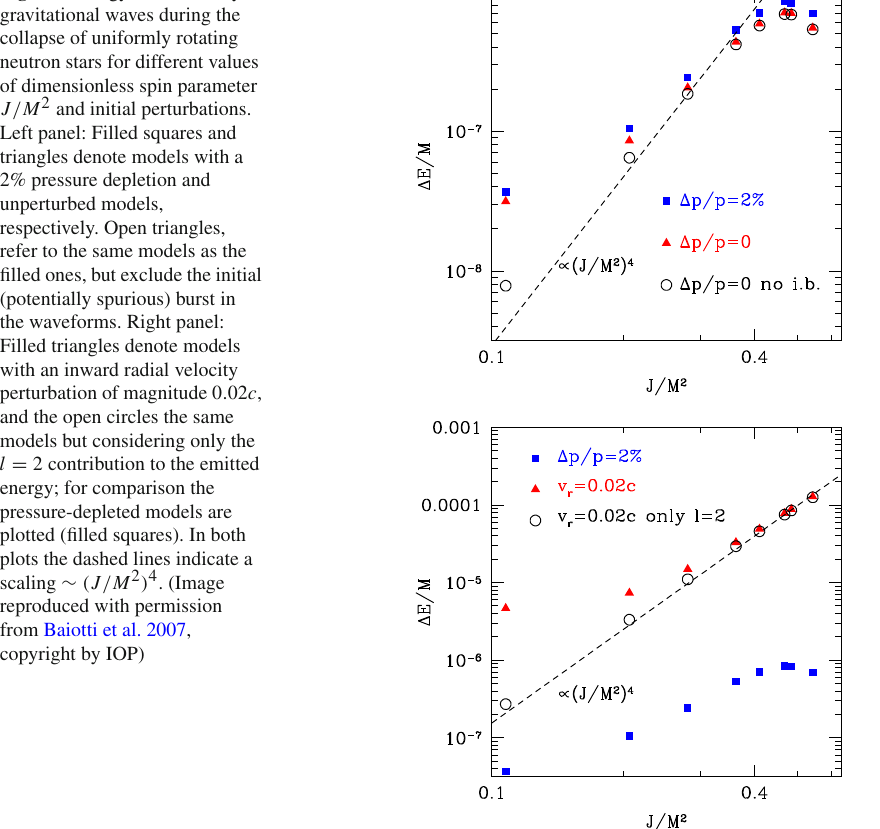
Fig. 24 Energy carried off by gravitational waves during the collapse of uniformly rotating neutron stars for different values of dimensionless spin parameter J / M 2 and initial perturbations. Left panel: Filled squares and triangles denote models with a 2% pressure depletion and unperturbed models, respectively. Open triangles, refer to the same models as the filled ones, but exclude the initial (potentially spurious) burst in the waveforms. Right panel: Filled triangles denote models with an inward radial velocity perturbation of magnitude 0 . 02 c , and the open circles the same models but considering only the l = 2 contribution to the emitted energy; for comparison the pressure-depleted models are plotted (filled squares). In both plots the dashed lines indicate a scaling ∼ ( J / M 2 ) 4 .